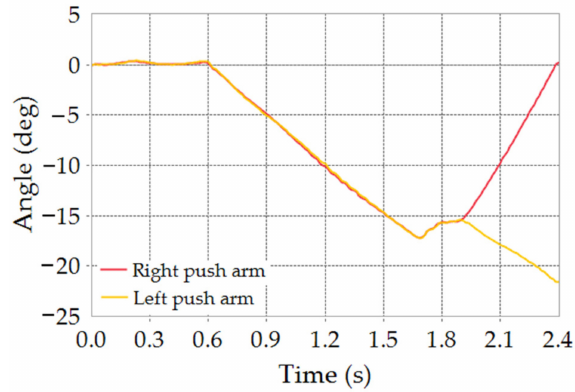
Figure 3. Rotation angles of the push